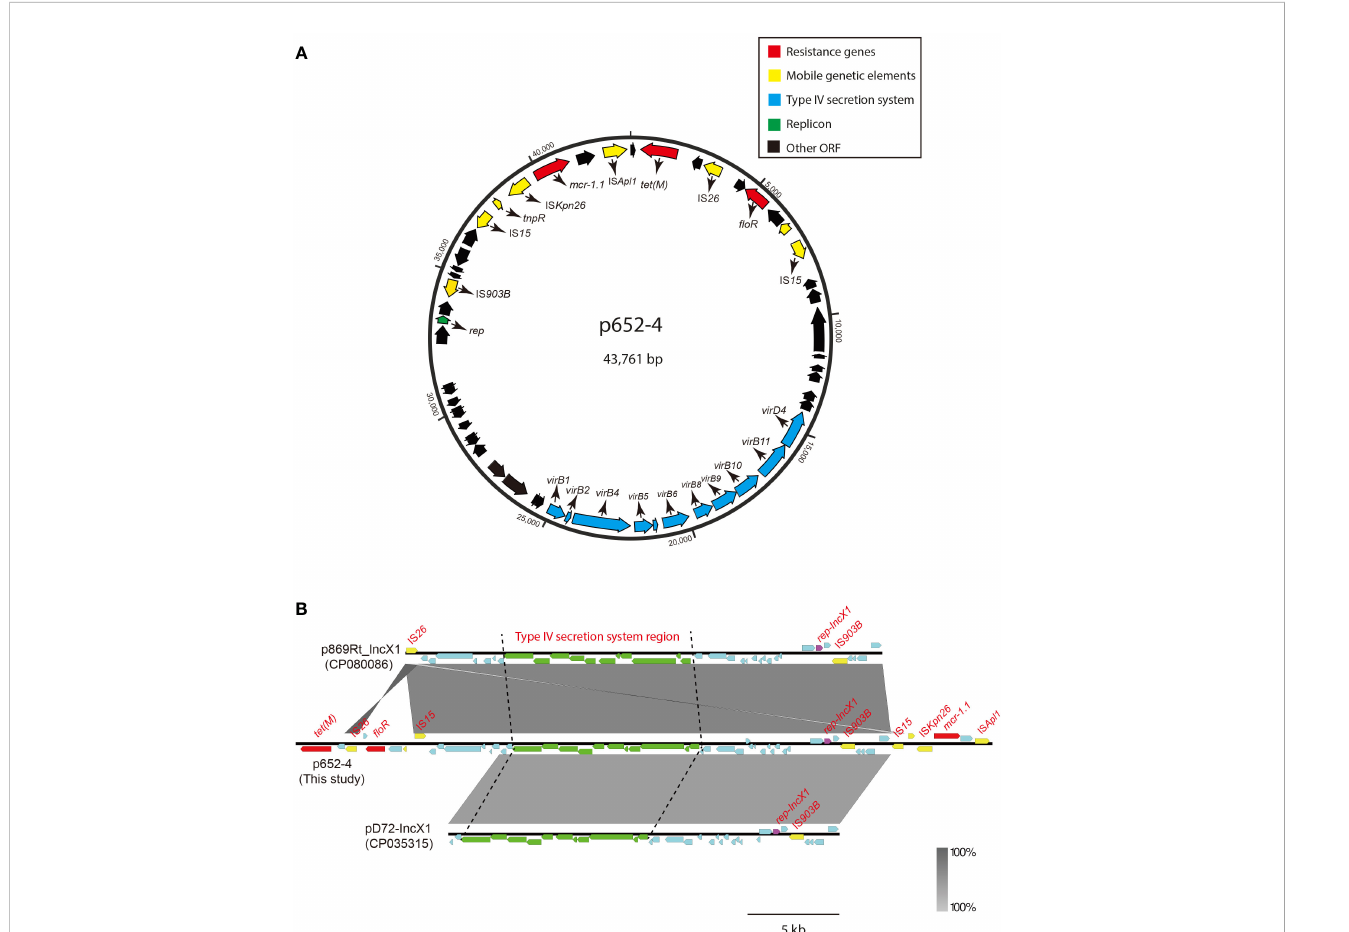
FIGURE 2 Circular map of plasmid p652-4 harboring mcr-1.1 and comparison with other IncX1 plasmids. (A) Blue arrows indicate the replicon. Red arrows indicate antimicrobial resistance genes. Yellow arrows represent IS elements. The blue arrows indicate the vir operon that plays a role in the Type IV secretion system (T4SS). The black arrows indicate other open reading frames (ORFs). (B) Plasmid comparison with p869Rt_IncX1 (CP080086) and pD72-IncX1 (CP035315). Near 100% identical sequences are bridged by gray shading. Red fi lled boxes indicate resistance genes. Yellow fi lled boxes indicate insertion sequences (ISs). Purple fi lled boxes indicate replicons. Green fi lled boxes represent the T4SS